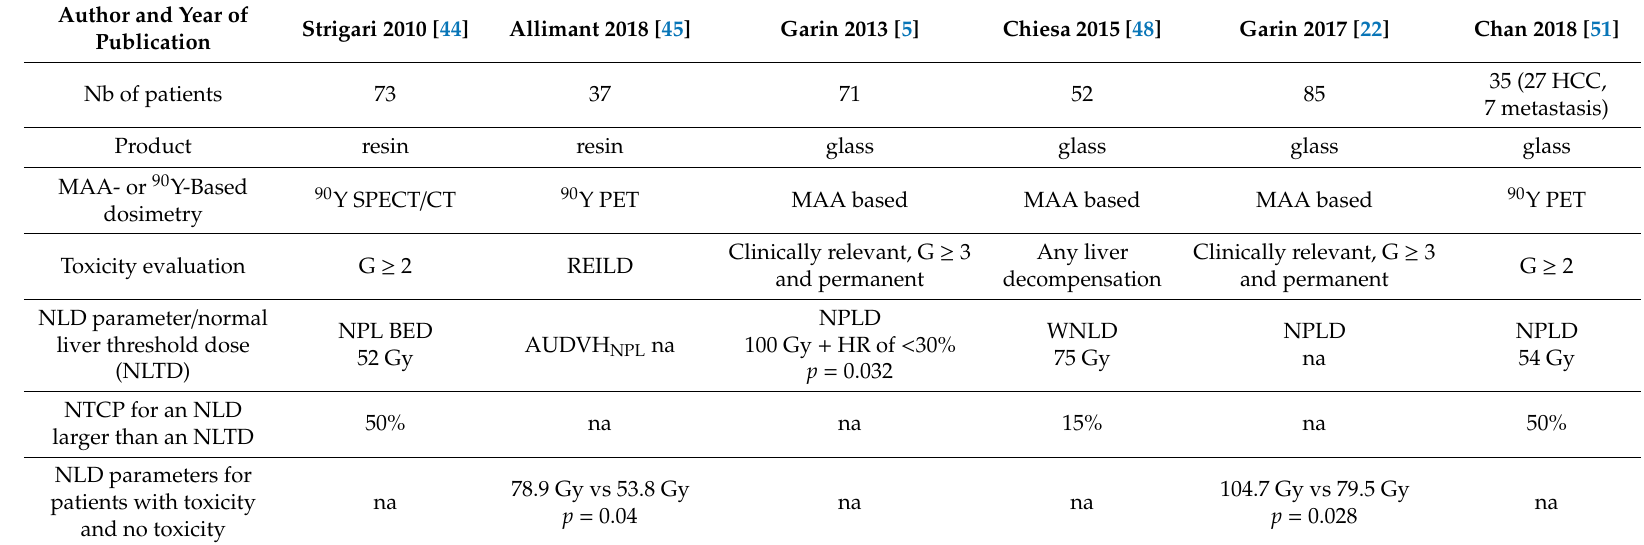
Table 3. Studies with NLD correlation with liver toxicity in HCC patients using resin and glass